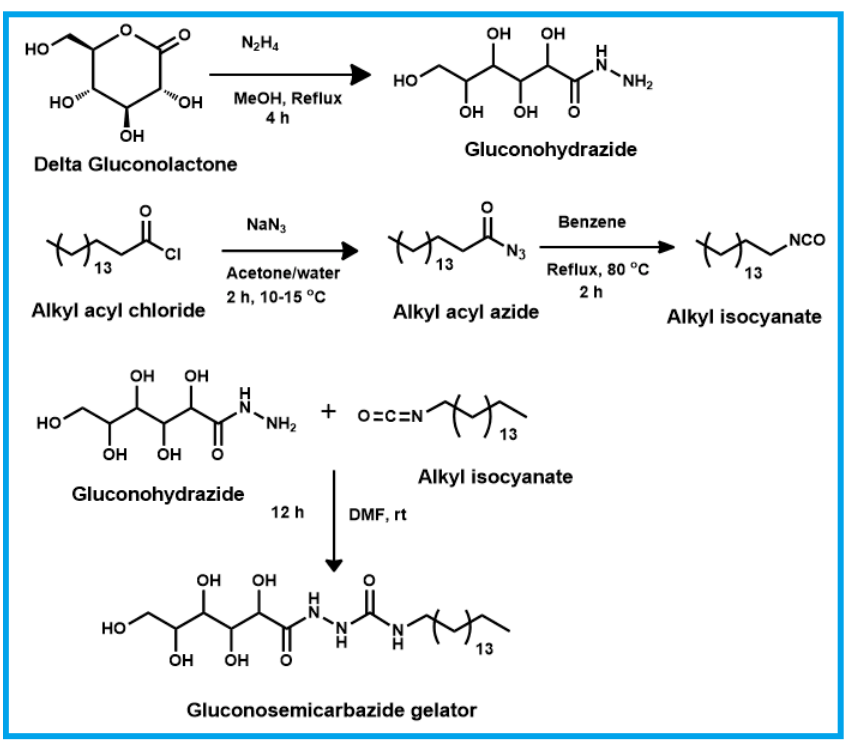
Figure 7. Schematic route to synthesize gluconosemicarbazide gelator.